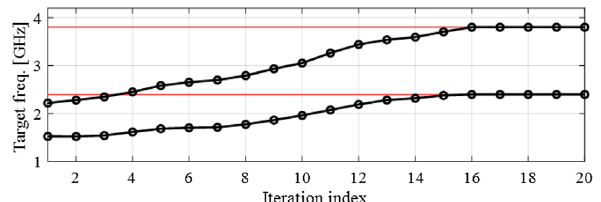
Figure 15. Dual-band power divider: evolution of the target operating frequencies versus iteration index of the optimization algorithm. Original target frequencies marked using a horizontal lines.